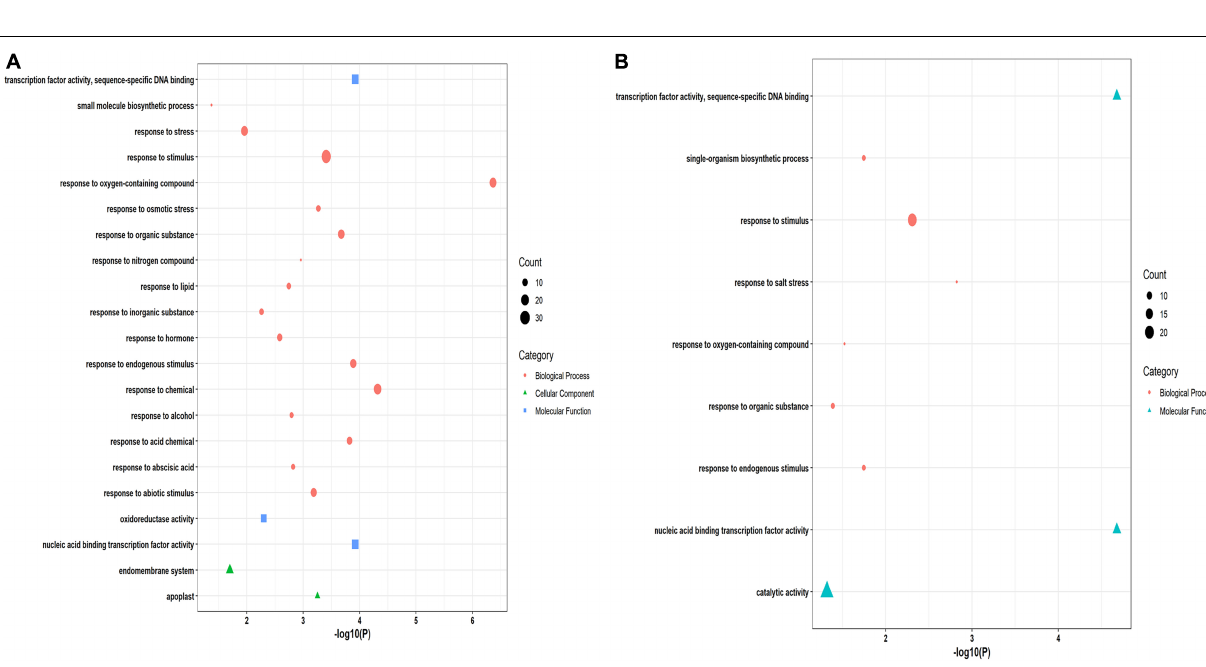
Frontiers in Plant Science |